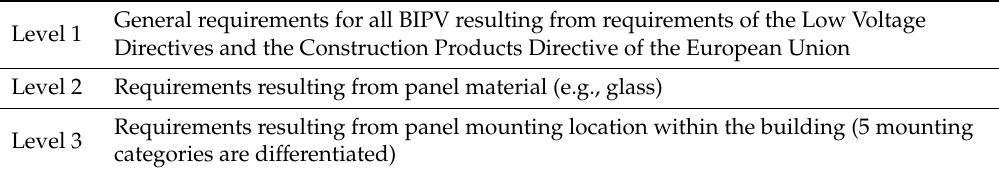
Table 2. Levels of di ff erentiations EN